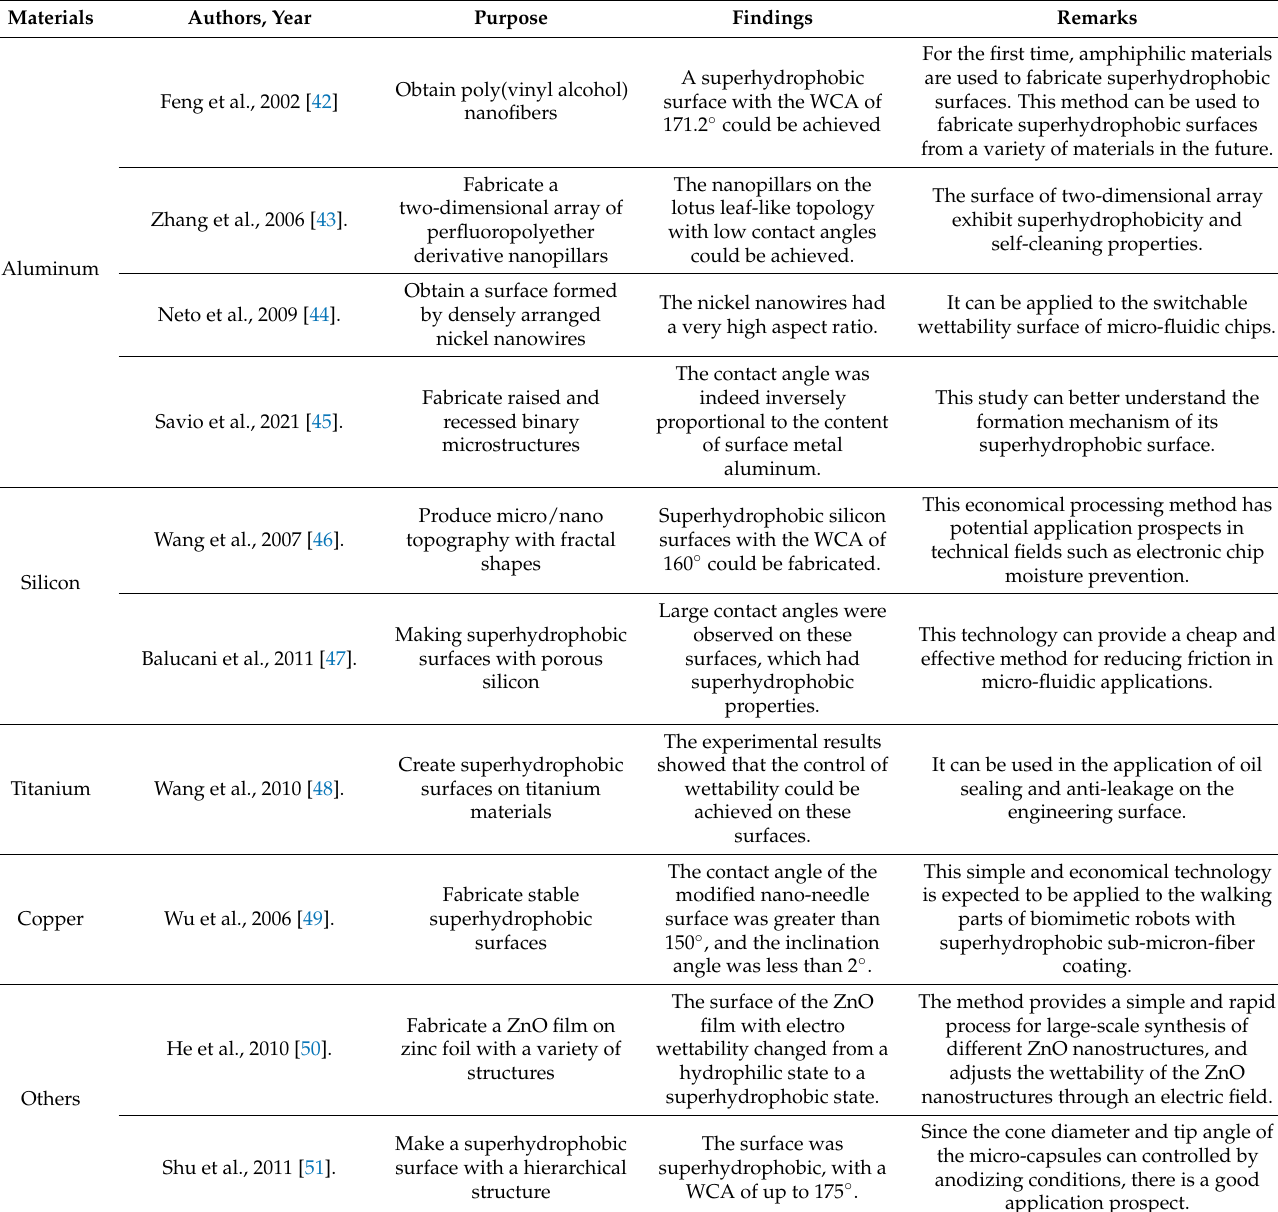
Table 3. Summary of electrochemical oxidation process described in the text grouped by materials fabricated.